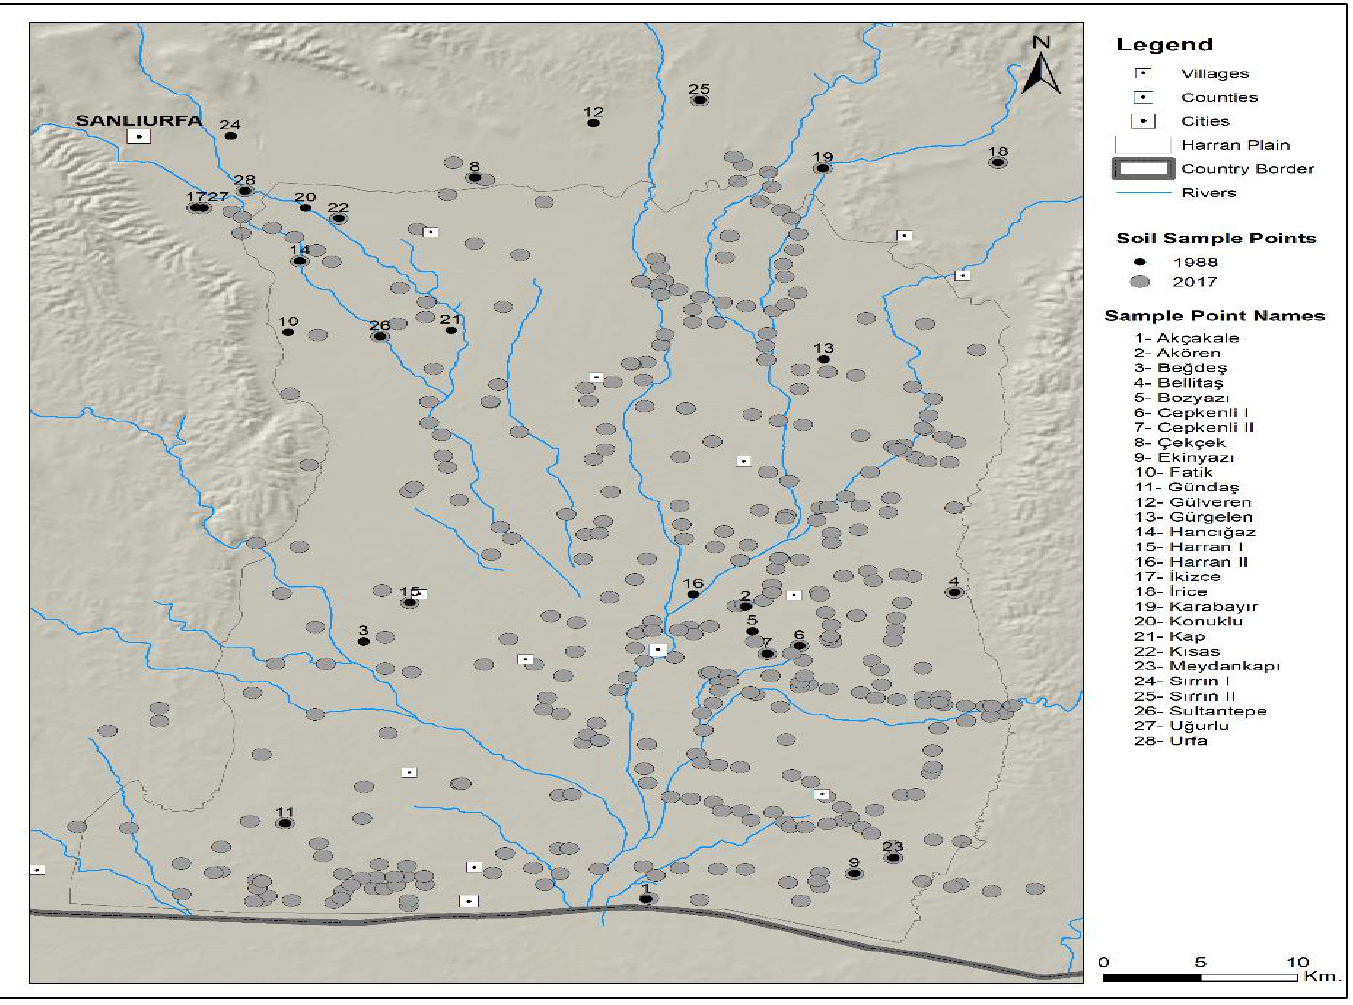
Figure 2: Soil sampling